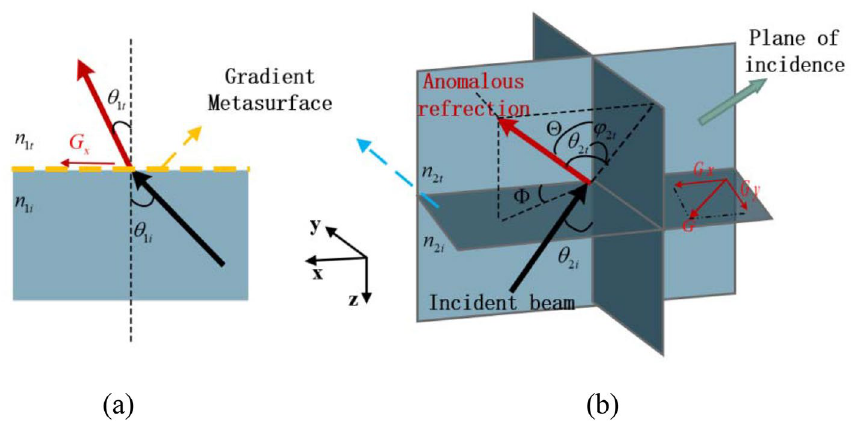
Figure 2. ( a ) 2D and ( b ) 3D generalized Snell’s law of